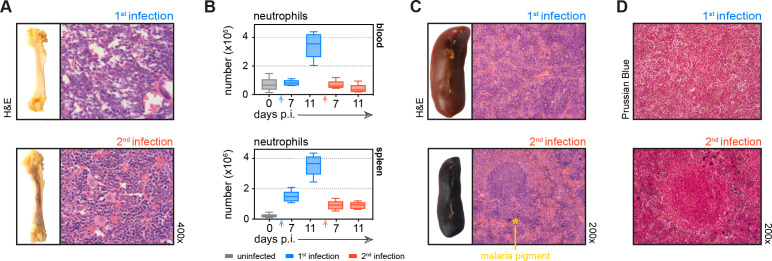
Tissue architecture is preserved and key homeostatic processes are maintained in tolerised hosts.(A) Paraffin-embedded femur sections were H&E stained during the acute phase of first or second infection (11 days p.i.). (B) Neutrophils from mice experiencing their first (n = 5 per time point) or second (n = 5–10 per time point) infection were analysed by flow cytometry (box-plots show median and IQR). Uninfected age-matched controls were analysed at each time point and pooled for graphing (n = 12). (C and D) Paraffin-embedded spleen sections were H&E (C) or Prussian Blue/Neutral Red (D) stained during the acute phase of first or second infection (11 days p.i.). Note that malaria pigment deposited during first infection persists and can still be observed during reinfection (marked with an asterisk). See Supplementary file 1 for all antibody panels and gating strategies.